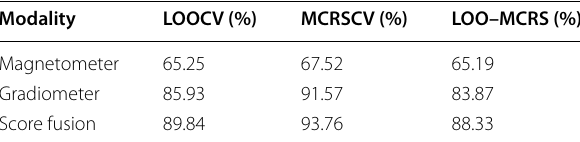
Table 4 Comparison of the evaluation methodologies; the proposed hybrid approach is referred as LOO–MCRS